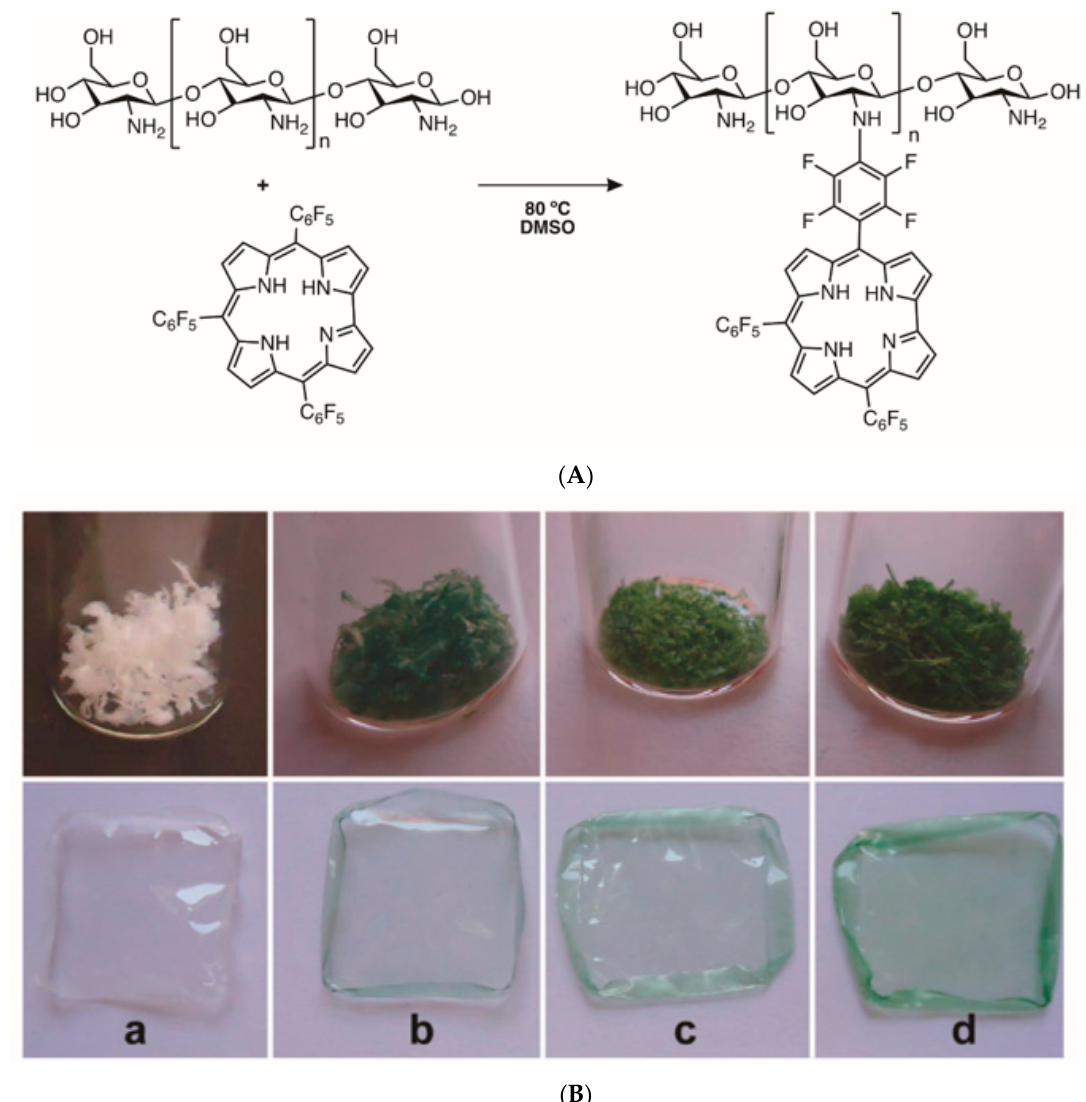
Figure 18. ( A ) Conditions used to graft 5,10,15-tris(pentafluorophenyl)corrole in chitosan. ( B ) Visual appearance of chitosan ( a ) and of corrole grafted-chitosan derivatives obtained after different reaction times [( b ) 6 h, ( c ) 24 h, and ( d ) 48 h], and of the corresponding films. Reproduced from Reference [30] with permission from the American Chemical Society.